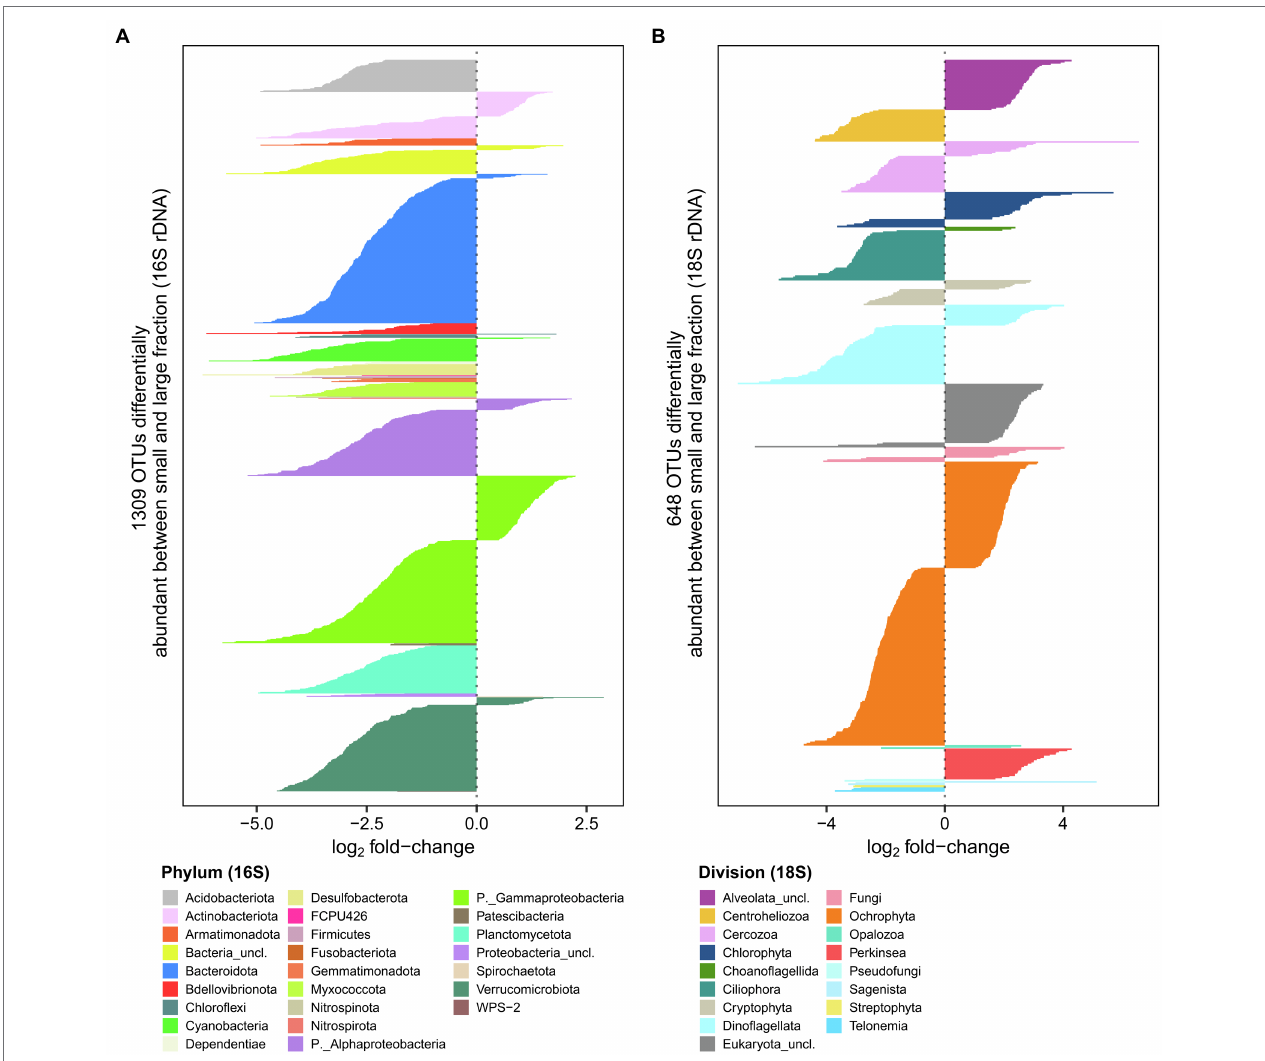
FIGURE 6 | Comparison of large and small fractions for bacterioplankton (A) and microbial eukaryotes (B) . Negative values represent rDNA OTUs more abundant in the large fraction, while positive values represent OTUs more abundant the small